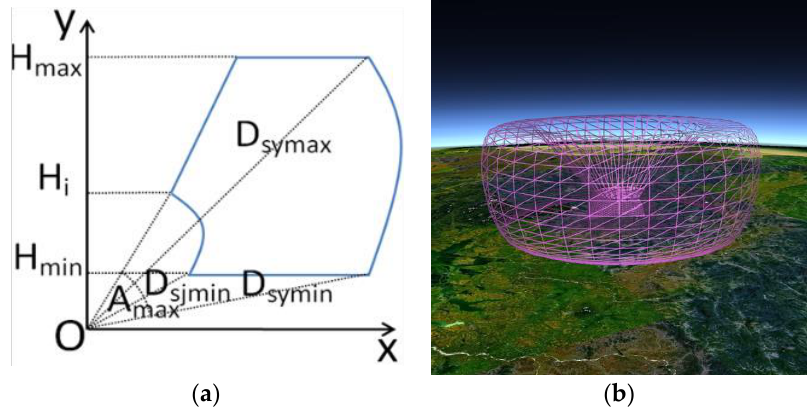
Figure 4. ( a ) Model of a missile killing zone; ( b ) 3D visualization of a missile killing zone.